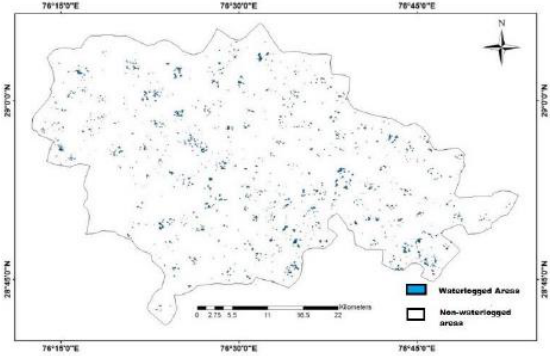
Fig 12 : Surface waterlogged areas within the Table 13: Results of surface waterlogged areas within canal buffer